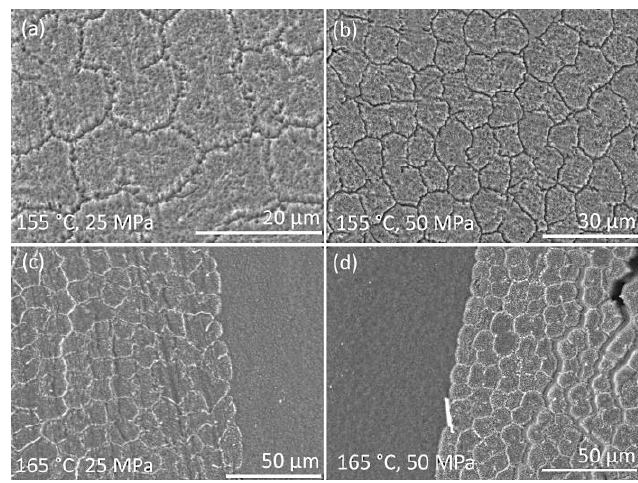
Figure 6. SEM images of the SRC’s and hybrid composites’ surface of samples obtained at 155 °C, 25